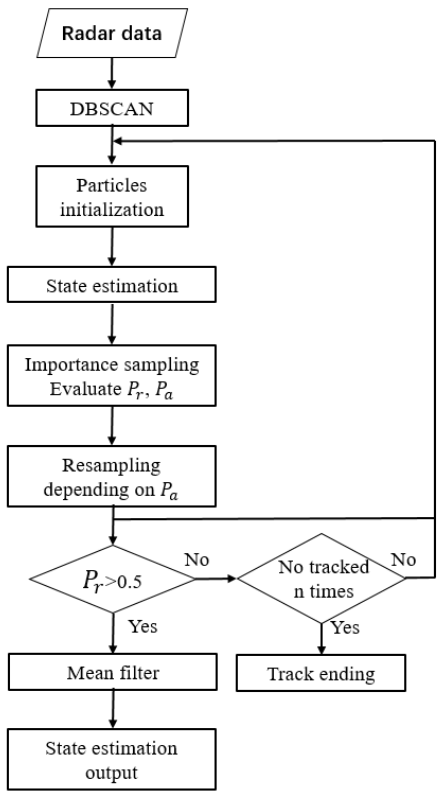
Figure 2. Flow chart of a radar-based object detection subsystem.